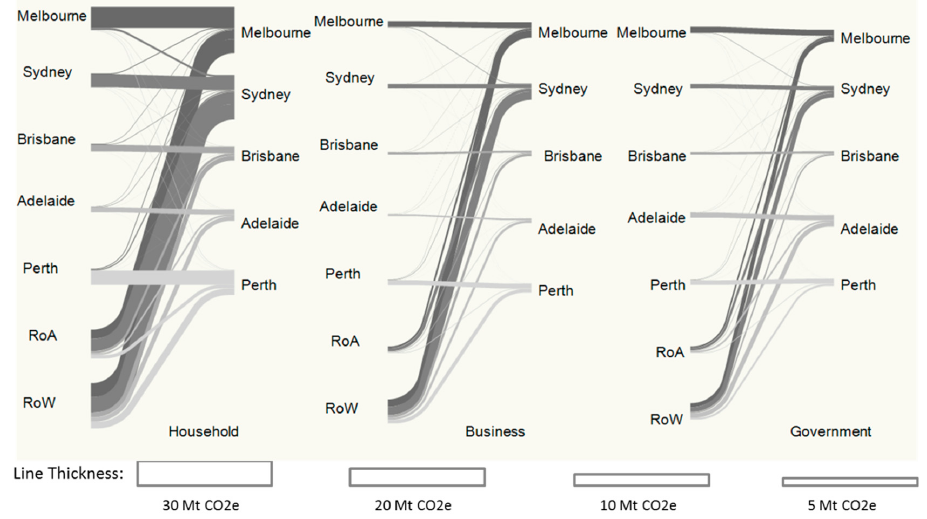
Figure 7. GHG emissions responsibility (CF) allocated to households, businesses and government (origin of emissions on the left-hand side; allocated CF of final demand on the right-hand side). Of the emissions driven by household consumption, 29%–57% originate within the city territory, with 14%–27% from RoA and 26%–38% from RoW. A slightly lower percentage of the emissions driven by business consumption originate within the city boundary (24%–54%), more are from the RoW (39%–51%), and only 6%–18% are from RoA. Emissions driven by government consumption originate 35%–64% from within the city territory, 26%–39% from RoW and 8%–19% from RoW.